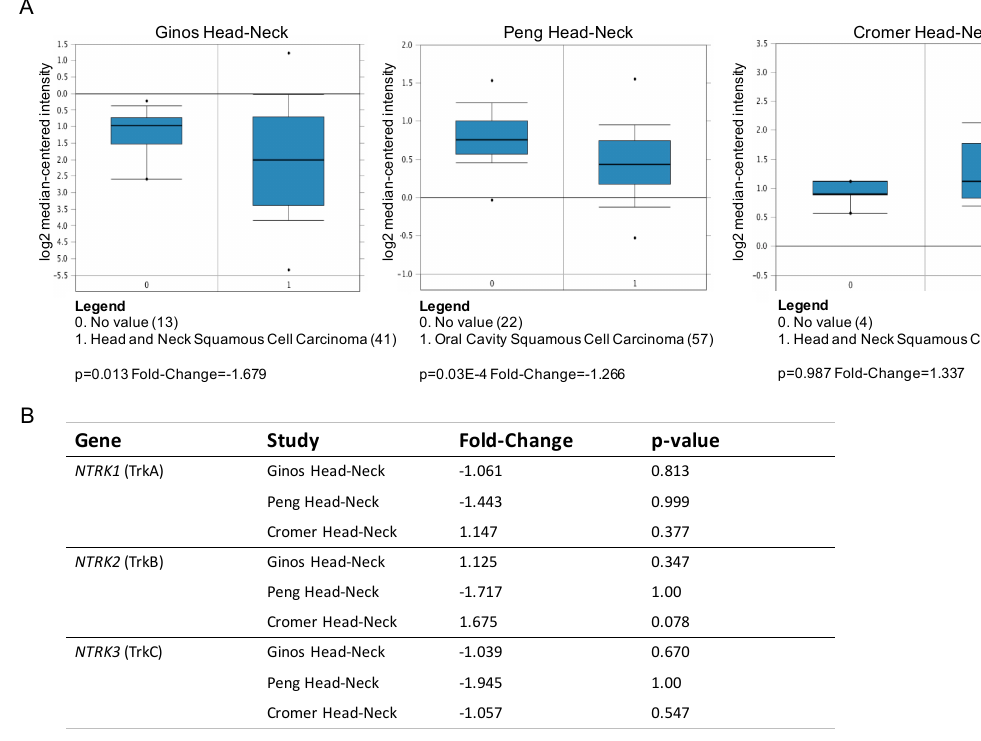
Figure 1. CD271 receptor expression in squamous cell carcimoma in vitro. ( A ) Left panel, CD271 expression in normal human keratinocytes (NK), keratinocytes from primary squamous cell carcinoma (SCC), and SCC15 cell line (SCC15) by Western blotting. Right panel, CD271/ β -actin RQ (relative quantification) by densitometry analysis performed by ImageJ software. ( B ) Percentage of CD271 positive cells in SCC12B, SCC13, and SCC15 cell lines evaluated by FACS analysis. ( C ) Total area (or spheroid size) of SCC cell line derived spheroids, evaluated by ImageJ software analysis at 24 h after SCC cell plating. ( D ) Upper panel: representative images of SCC12B, SCC13, or SCC15 derived spheroids. Scale bar = 100 μ m. Lower panel: SCC12B, SCC13, or SCC15 image masks generated from ImageJ software analysis and used to calculate the total area/size of each spheroid. For all results, data represent the mean from three independent experiments ± SEM. * for p < 0.05, ** for p < 0.01.